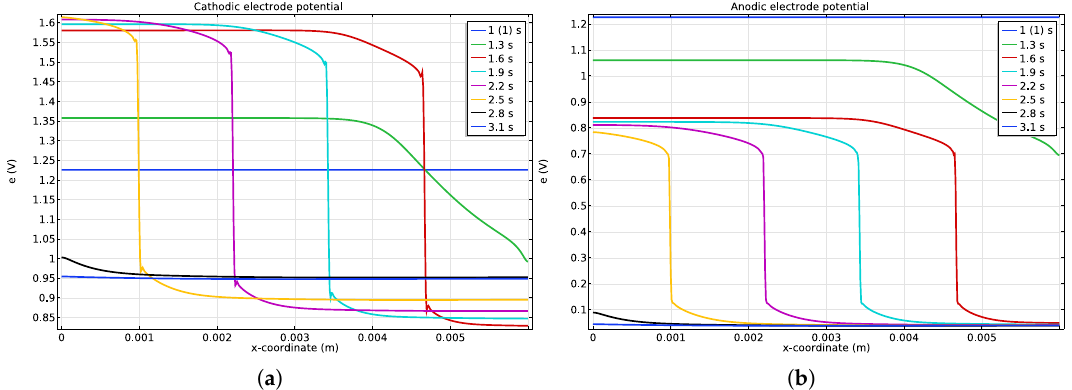
Figure 3. Potentials along the channel ( a ) cathode, and anode ( b ) catalyst layer during a startup. The hydrogen is injected only at t = 1 s in order to let the simulation reach stationary conditions before startup.